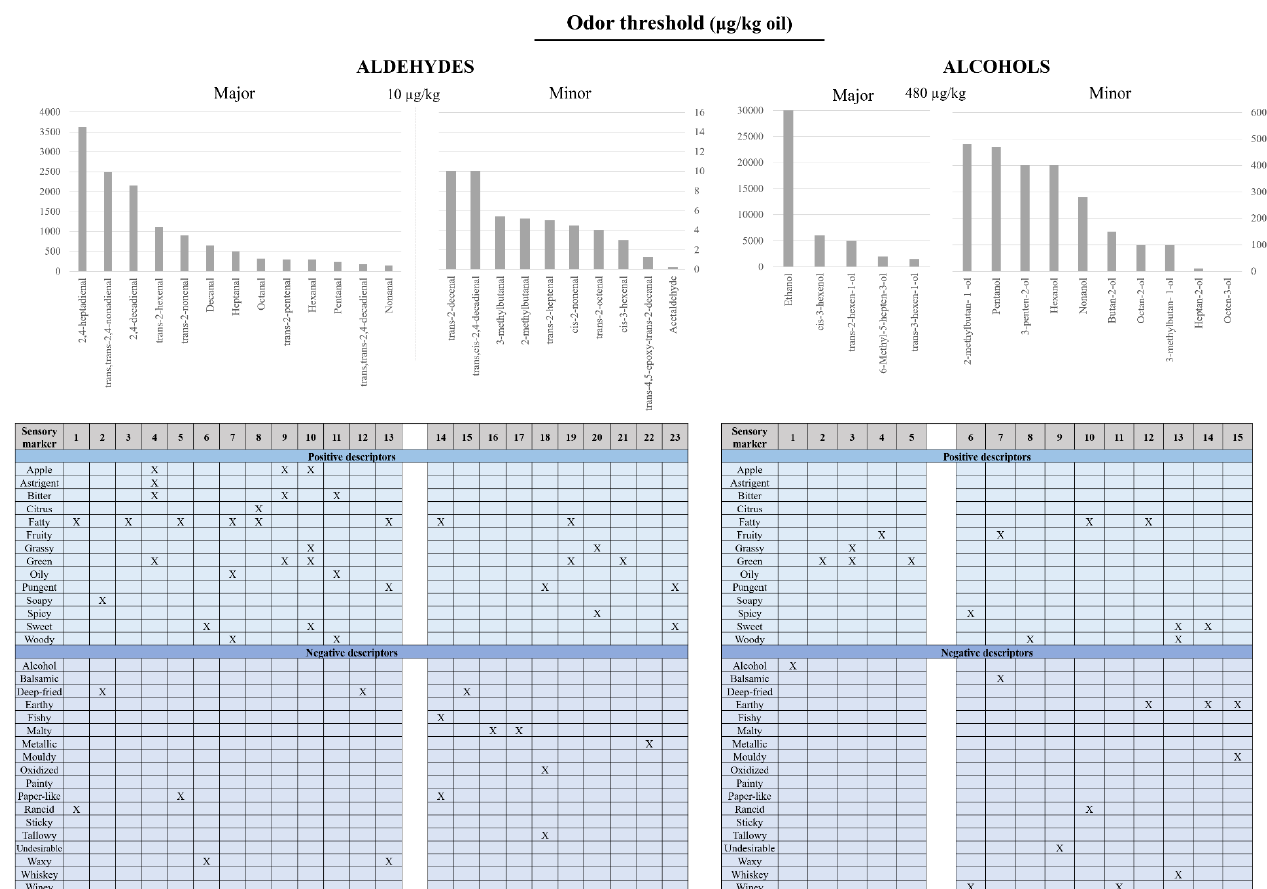
Figure 1. Odor thresholds and sensory descriptors of aldehydes and alcohols in olive oil.